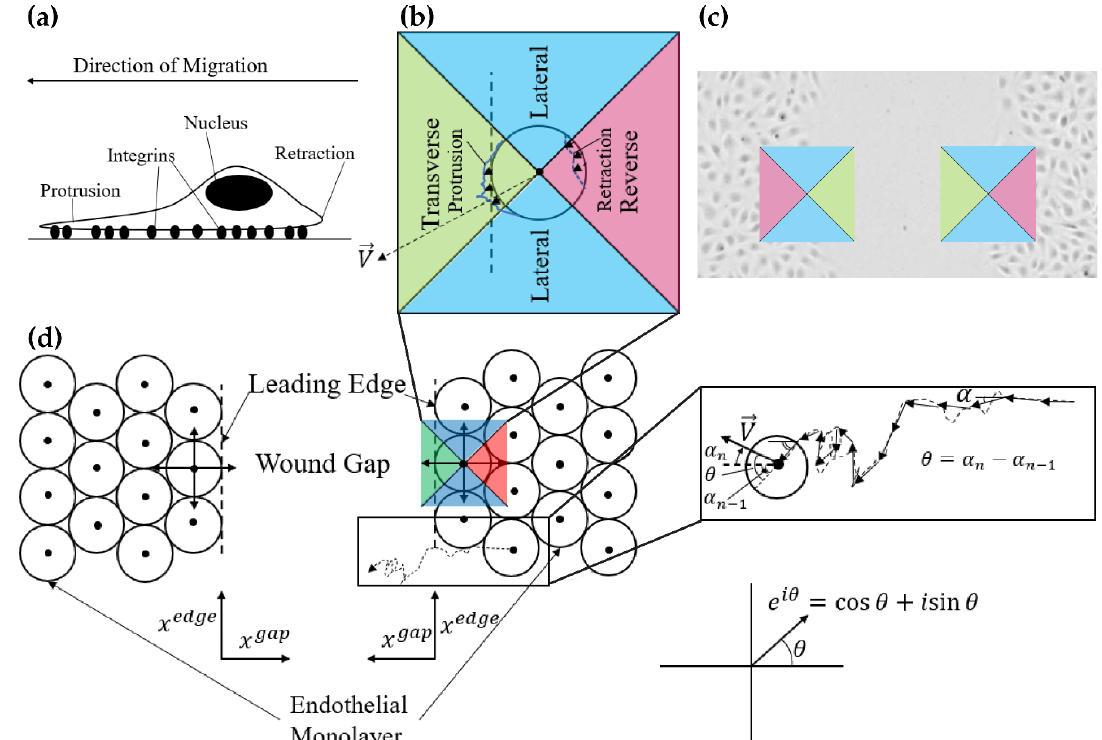
Figure 1. ( a ) Simple schematic detailing endothelial cell migration at the cellular level; ( b ) Visual representation of the migration zone convention is denoted by: Transverse (across the gap), lateral (generally parallel to the leading edge), and reverse (opposite to the gap) directions in the context of the leading edge of a wound. In healing, cell transverse velocities are ideal (moving across the gap), the reverse region is antithetical to wound healing, and velocities in the lateral region are neither as bad as the reverse region nor as good as the transverse region; ( c ) Migration zones in the context of a wound healing assay; ( d ) A simplified model of a wound healing assay. In this view, one may more clearly see the transverse, lateral, and reverse zones in relation to the leading edge. A representative single EC motion is identified, and we denote the equation for the turning angle θ . Note that the sign of the angle is important (counterclockwise form the horizontal is positive). Lastly, we show the representation of a two-dimensional vector as a polar complex number, which was used for brevity throughout the